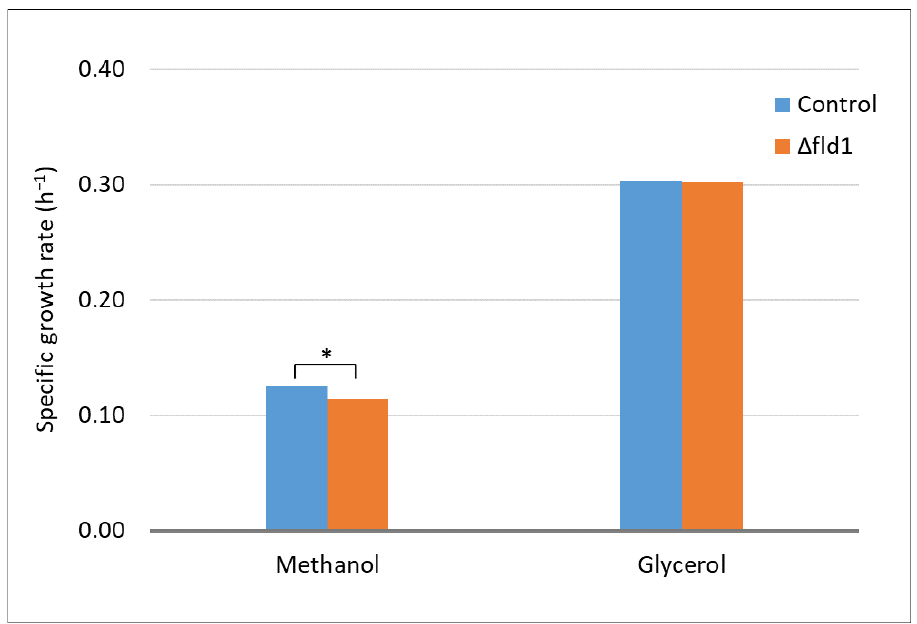
Figure 2. Specific growth rate ( µ ) of control and Δ fld1 strains grown on a defined medium using either methanol or glycerol 3 g/L as the only carbon source. * Significant difference evaluated by an unpaired t-test * p < 0.01. Cell growth profiles are shown in Supplementary Figures S2 and S3.